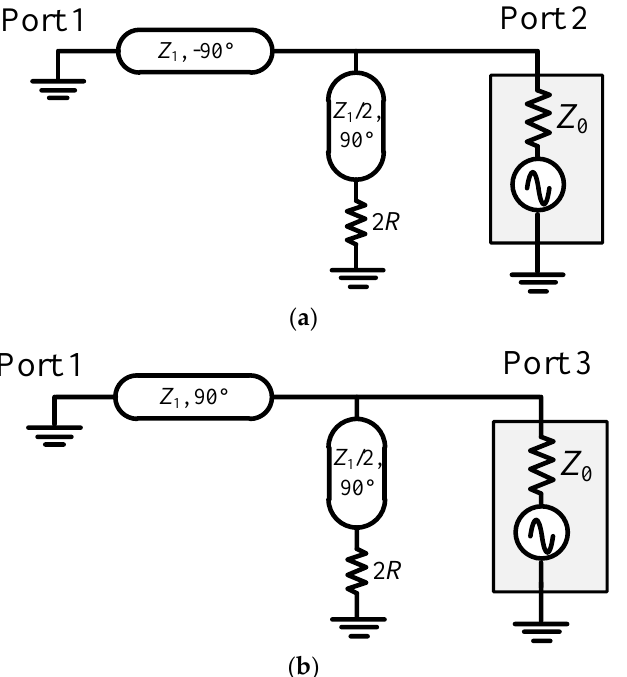
Figure 3. Schematic of the odd − mode circuits between ( a ) Port 1 and Port 2 and ( b ) Port 1 and Port 3.